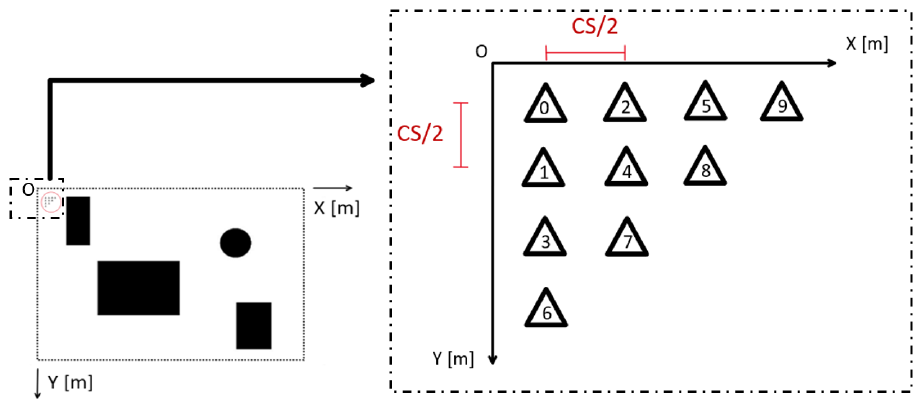
Figure 2. The initial configuration of the fleet of UAVs. This initial condition is assumed in most of the simulations performed in this